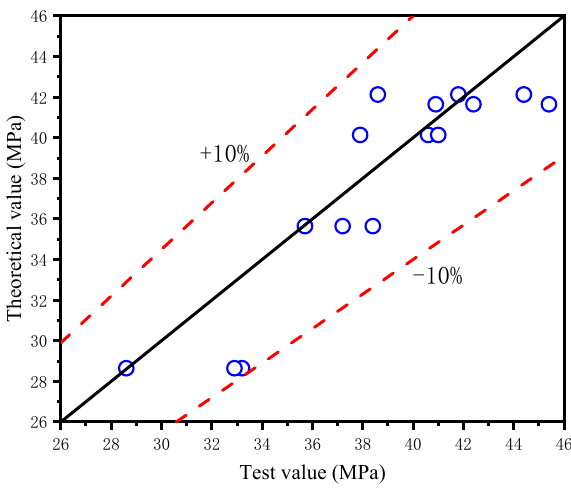
Figure 19. Comparison of the theoretical and test values.